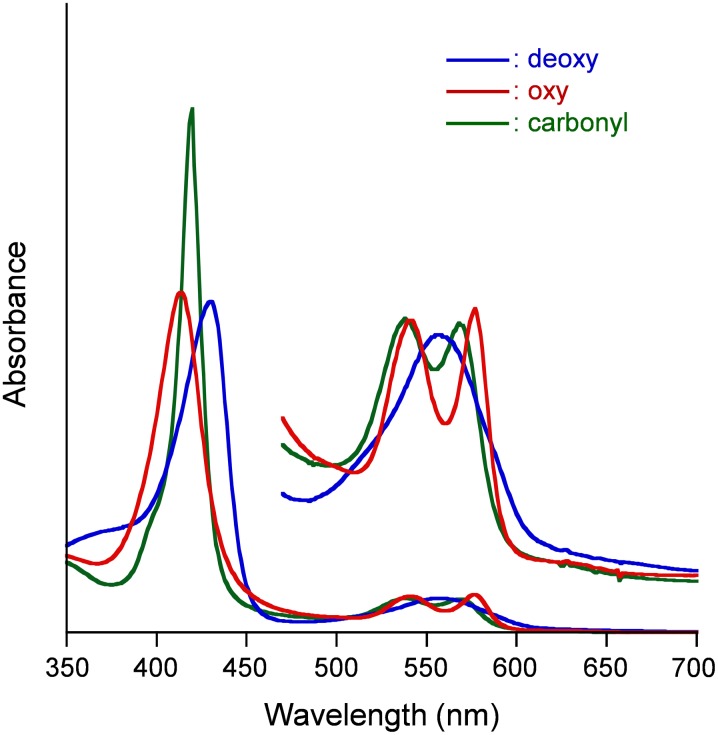
Visible absorption spectral changes of Hb-HSA3 cluster.In PBS solution (pH 7.4) at 25°C.